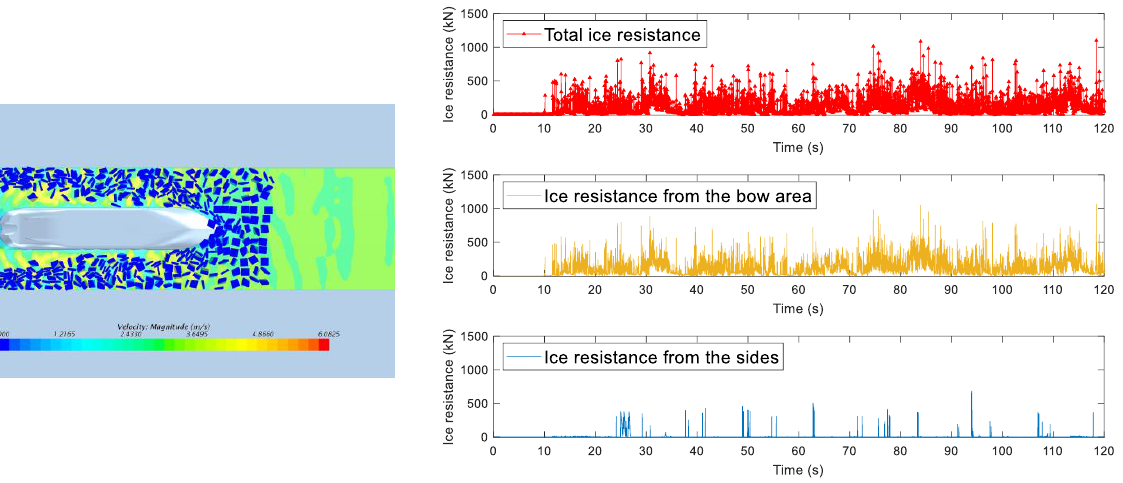
Figure 13. Simulation and ice resistance of Case A: the side-nozzle ventilation rate is 1 m/s; the bow-nozzles are turned off.